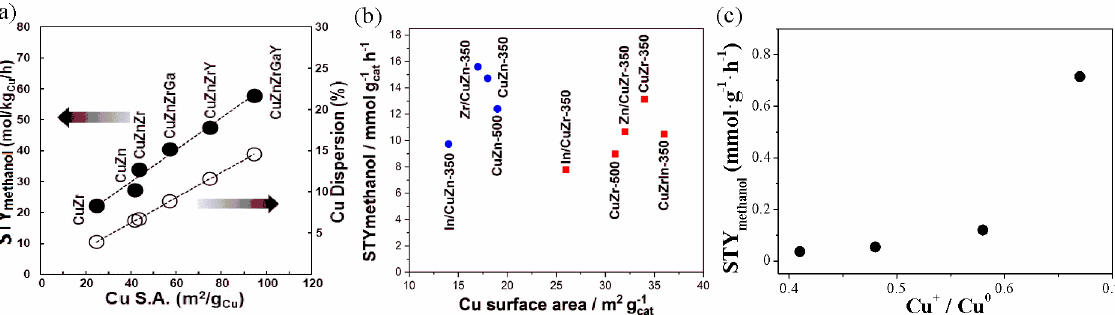
Figure 4. Correlation of space – time yield of methanol (STY methanol ) with ( a , b ) Cu surface area (S.A.) and ( c ) molar ratio of Cu + /Cu 0 . The Cu S.A. is measured by temperature-programmed desorption of N 2 O. The ratio of Cu + /Cu 0 is characterized by X-ray photoelectron spectroscopy. Reaction conditions: ( a ) T = 240 °C, P = 3 MPa, GHSV = 3000 mL·g − 1 ·h − 1 , H 2 /CO 2 = 3. ( b ) T = 230 °C, P = 3 MPa, GHSV = 3800 mL·g − 1 ·h − 1 , H 2 /CO 2 = 3. ( c ) T = 200 °C, P = 2 MPa, GHSV = 2000 mL·g − 1 ·h − 1 , H 2 /CO 2 = 3. Reproduced with permission from Natesakhawat et al. [47], Stangeland et al. [59] and Dasireddy et al. [62], respectively published by ACS Publications, 2012, Elsevier, 2021, and Elsevier,